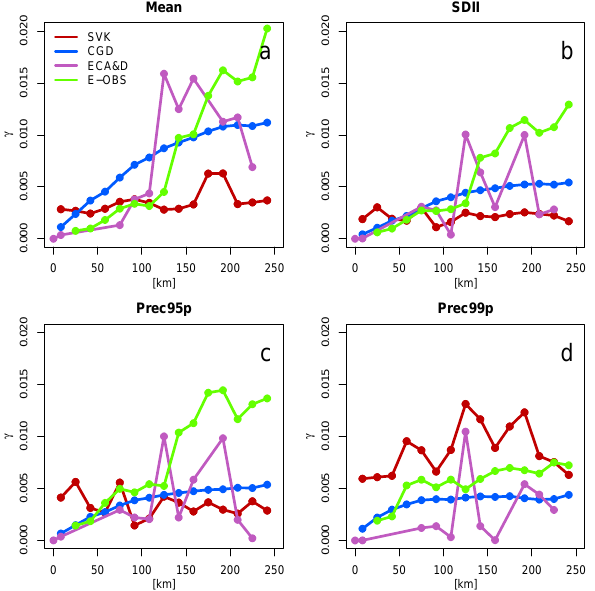
Fig. 4. Semivariograms of the mean precipitation (mean) (a) , the mean precipitation amount per wet day (SDII) (b) , and the differ- ent percentiles of extreme precipitation (Prec95p and Prec99p) (c, d) for all observational data sets showing the difference in spatial